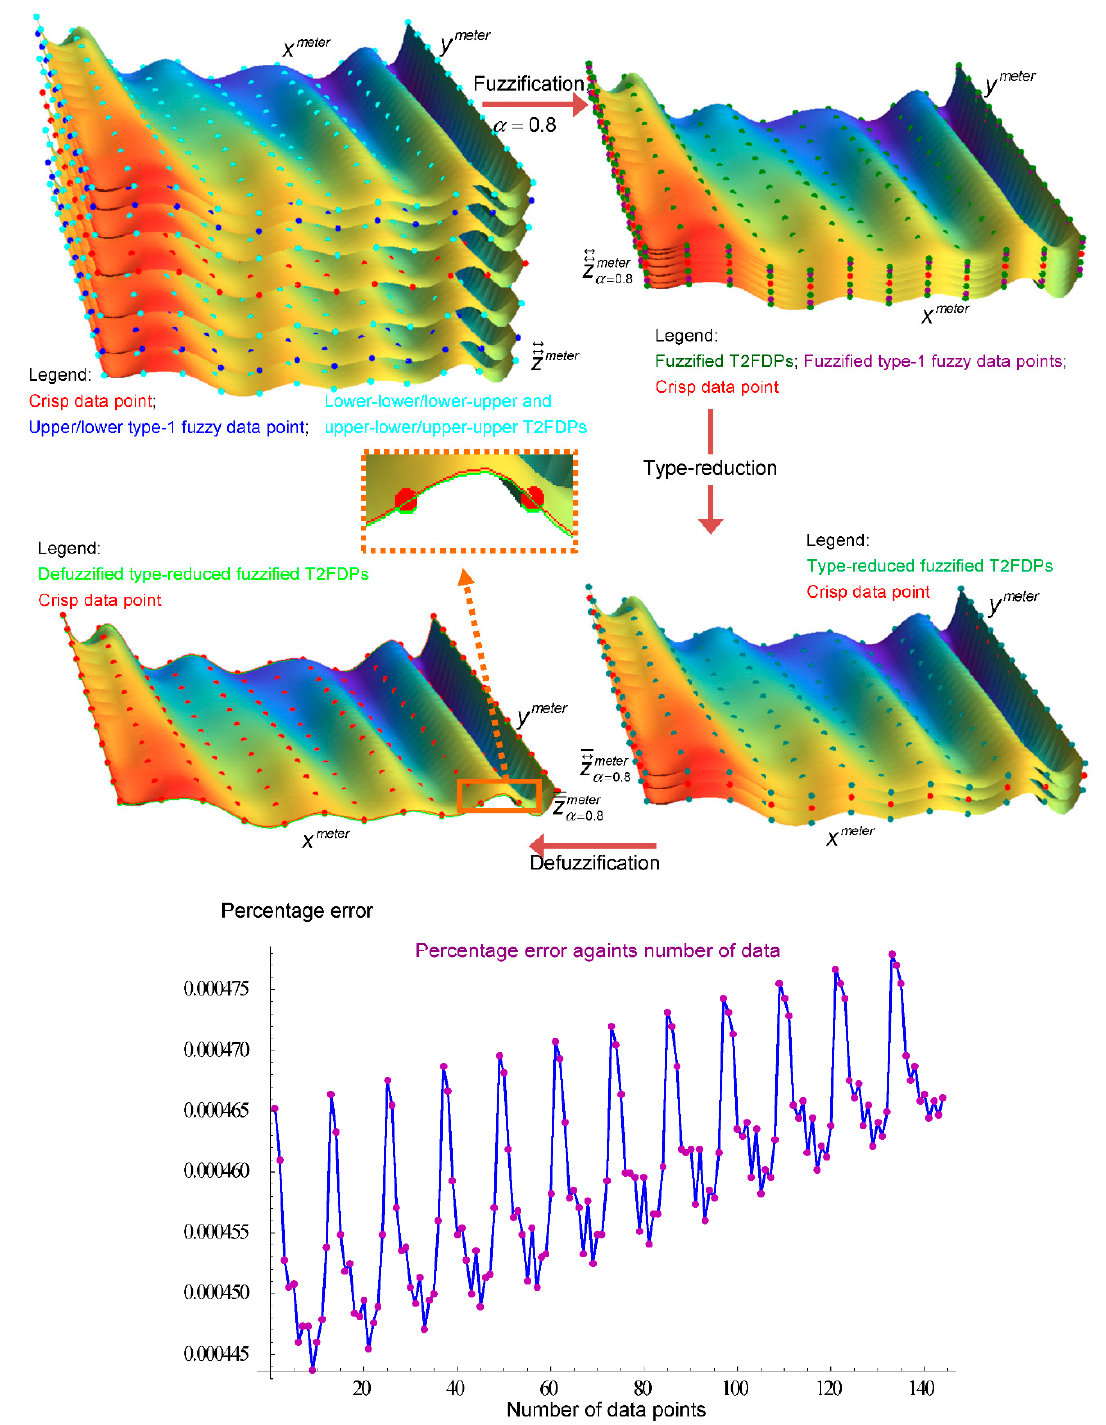
α= 0.8 along the error plot. Figure 14. The T2FIBsS modeling through fuzzification until defuzzification processes with α = 0.8 along the error